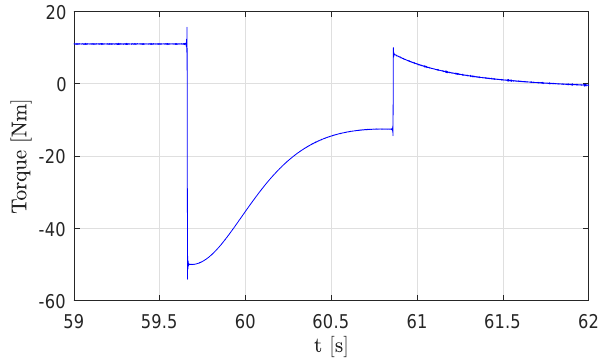
Figure 17: Electromagnetic torque of the servo